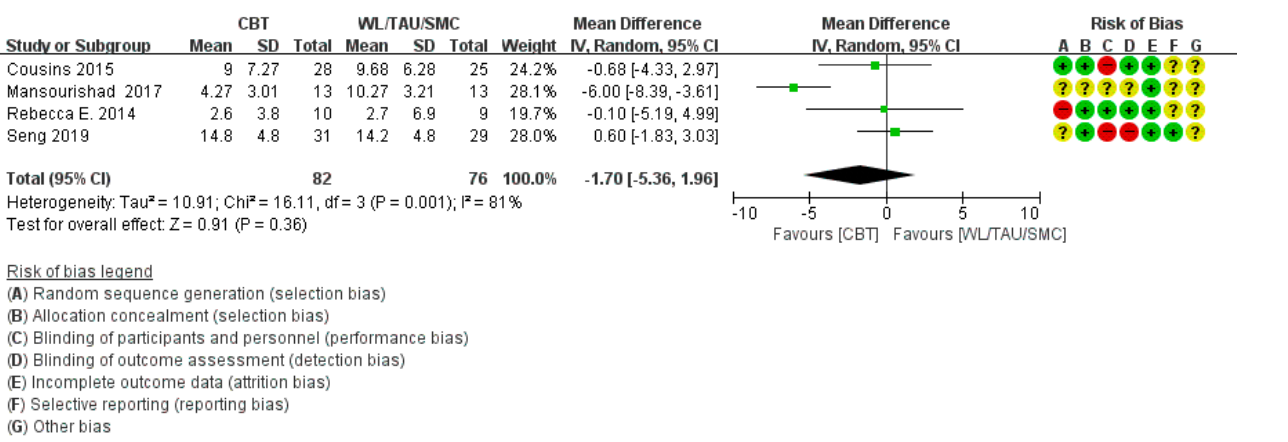
Figure 4. Subgroup analysis of cognitive behavioral treatment compared with the WL/TAU/SMC group regarding the difference from baseline in headache frequency.